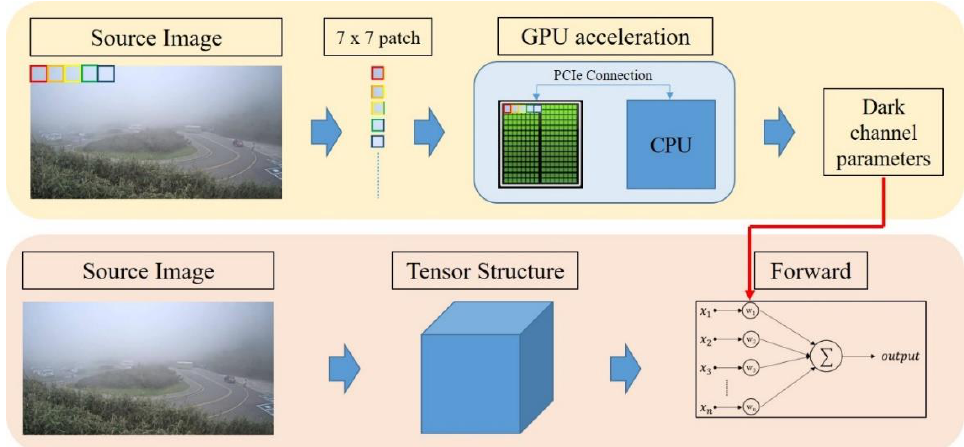
Figure 8. Graphics processing unit (GPU) acceleration flowchart.